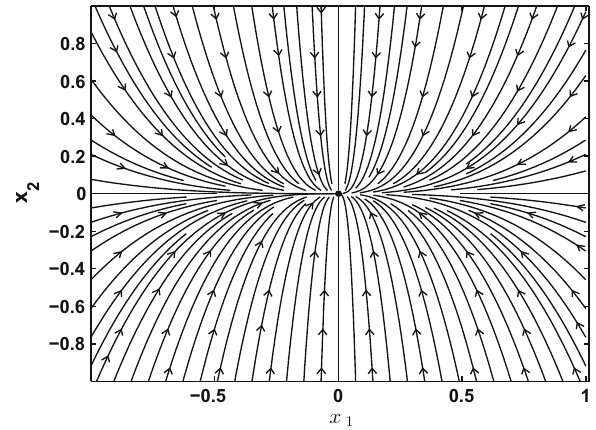
Fig. 1 Phase portraits for the system ( ˙ x 1 = − x 1 , ˙ x 2 = − 3 x 2 ). The dotted circle at the origin represents a fixed